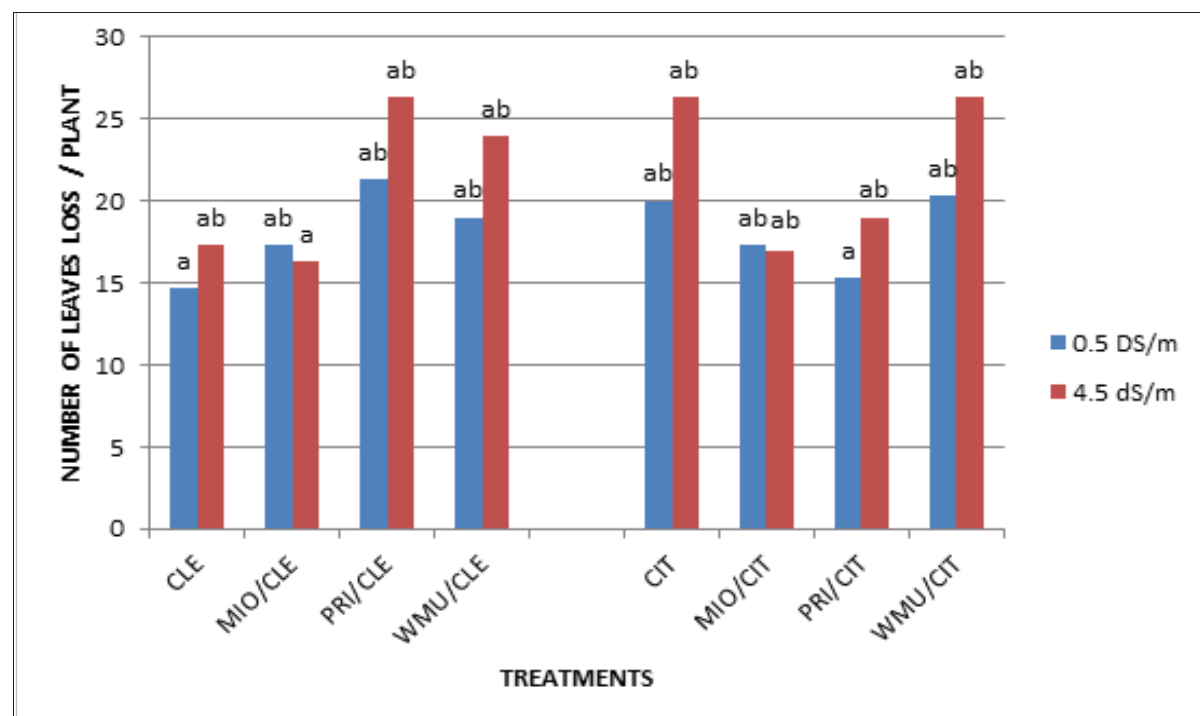
Figure 1. Effects of salt stress on leaves loss / plant of each scion/rootstock combination at 90 days. *CLE (‘Cleopat - ra’), MIO (‘Mihowase’), PRI (‘Primosole’), WMU (‘W. Murcott’), CIT (‘Swingle